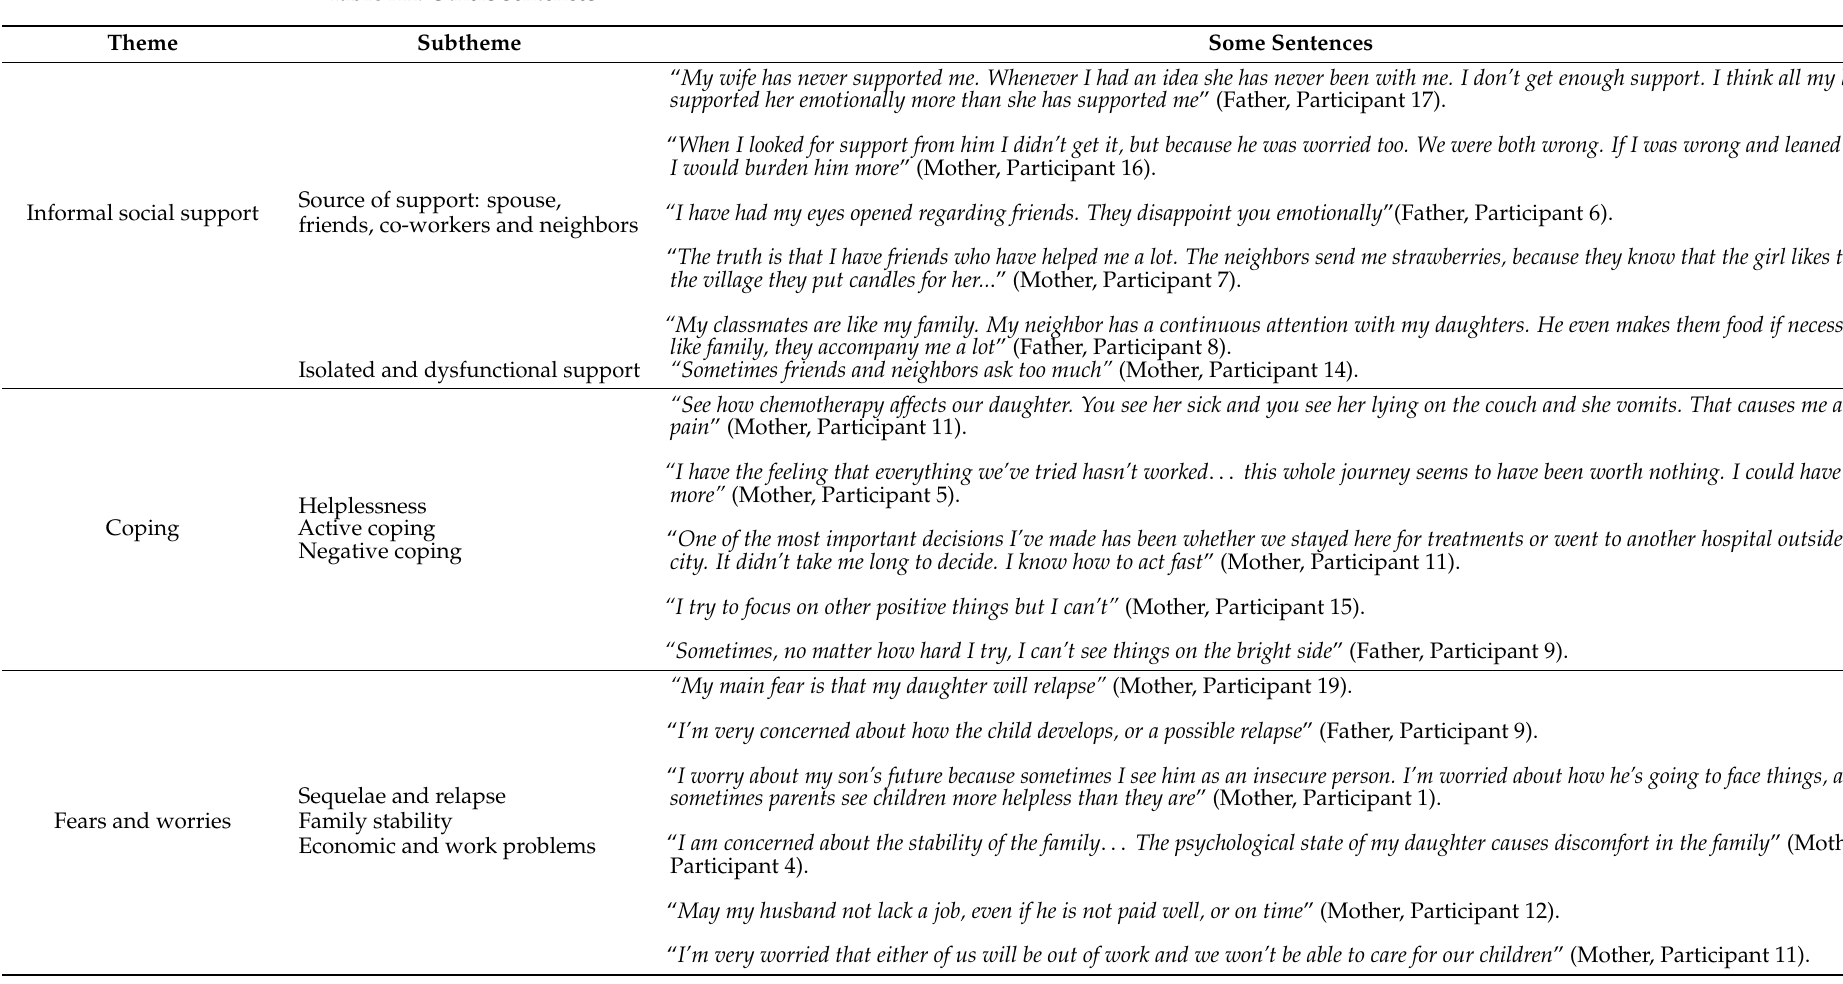
Table A1. Others